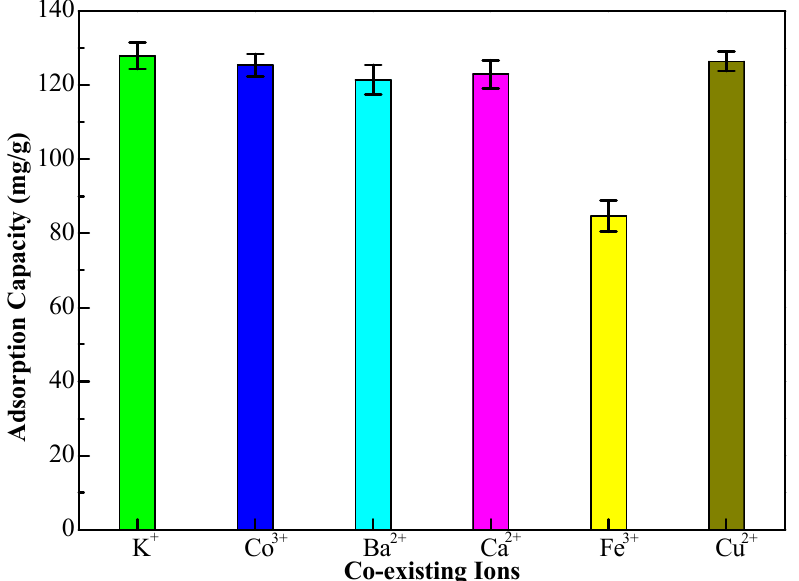
Figure 12. The adsorption capacity of 10%-Fe 3 O 4 @ SC adsorbent for Cr(VI) ions under the coexistence ions .